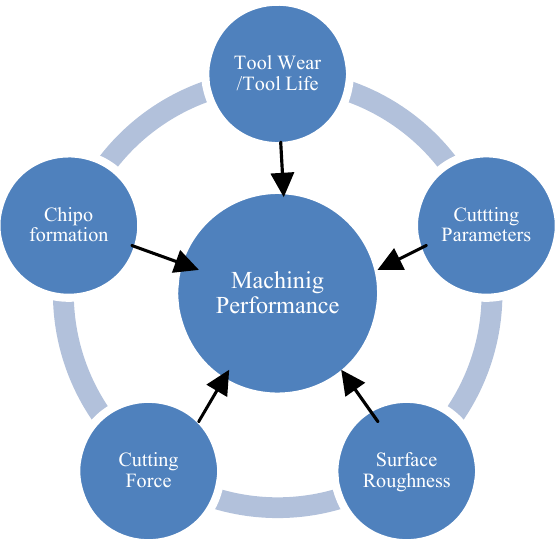
Figure 1. Factors affecting the machining